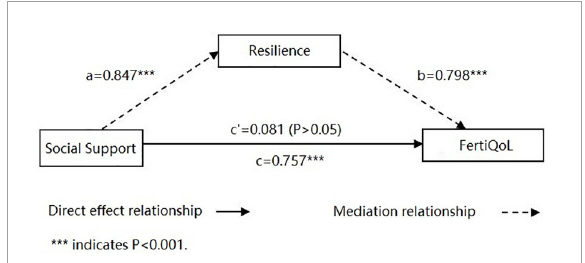
FIGURE1 The model of mediation for the impact of social support toward fertility-related quality of life (FertiQoL) with the mediation impact of resilience. *** P <